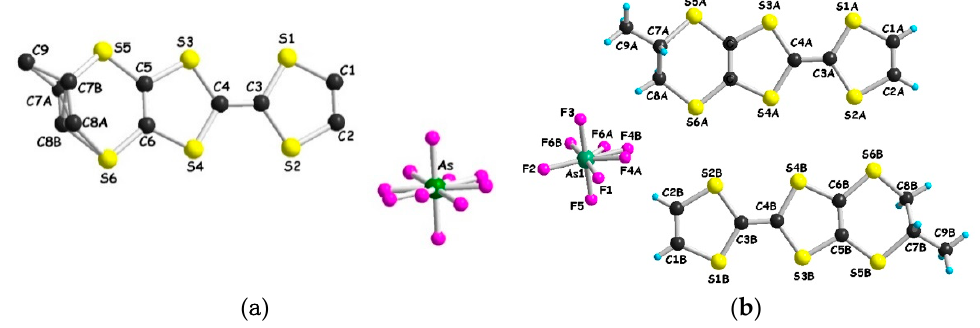
Figure 1. ( a ) Molecular structure of [( rac )- 1 ] 2 AsF 6 . H atoms have been omitted for clarity. Equatorial F atoms are disordered on two positions each (s.o.f. 0.66 and 0.34). The ethylene bridge is disordered over two positions A (s.o.f. 0.62) and B (s.o.f. 0.38); ( b ) Molecular structure of [( S )- 1 ] 2 AsF 6 . F4 and F6 atoms are disordered (s.o.f. 0.57 and 0.43). Contrary to the racemic form, the donor molecules of the enantiopure salts have no occupational disorder; the methyl substituent adopts equatorial conformation in both in- dependent molecules, and two of the fluorine atoms were modelled over two positions.